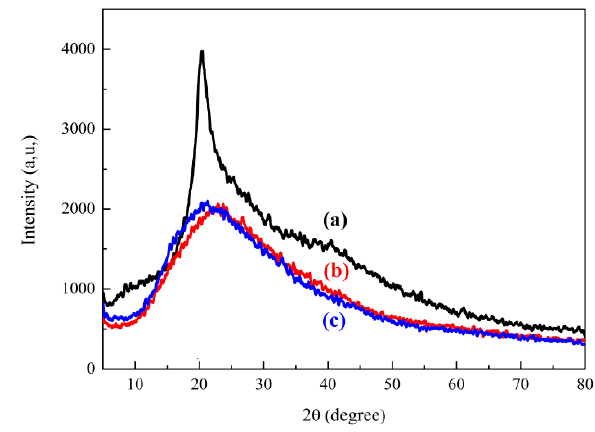
Figure 4. XRD spectra of ( a ) CMCS, ( b ) P(AM-DMC), and ( c ) CCPAD.